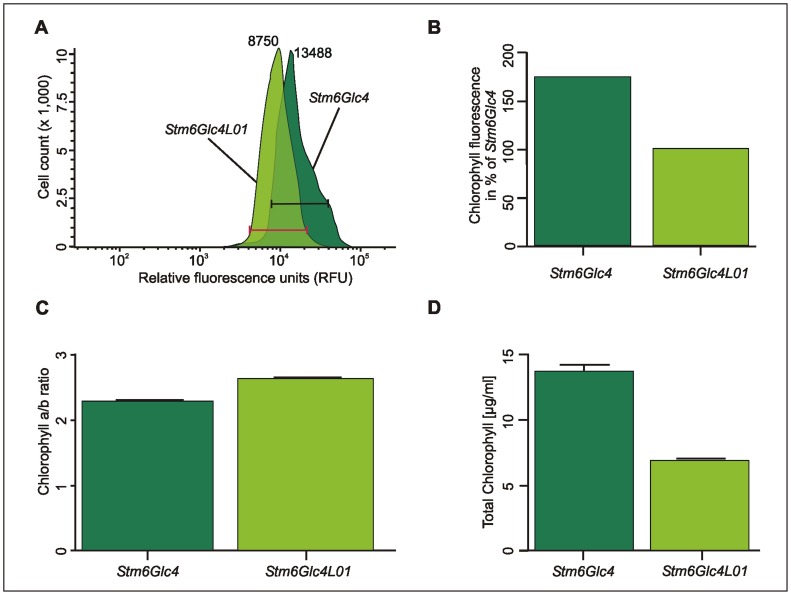
Chlorophyll fluorescence and chlorophyll yield in Stm6Glc4 vs. Stm6Glc4L01.(A) Graph derived from flow cytometry analysis showing relative fluorescence units (RFU) per cell. Over 2.7*105 cells were analyzed for each cell line. RFU range used to determine the mean is indicated by the red and black bars. (B) Mean chlorophyll fluorescence in percentage normalized to Stm6Glc4L01 (100%). (C) Chlorophyll a/b ratio of Stm6Glc4 and Stm6Glc4L01. (D) Total chlorophyll content in microgram per milliliter culture. Chlorophyll measurements (C, D) show results of two independent experiments with 7 replicates in total.